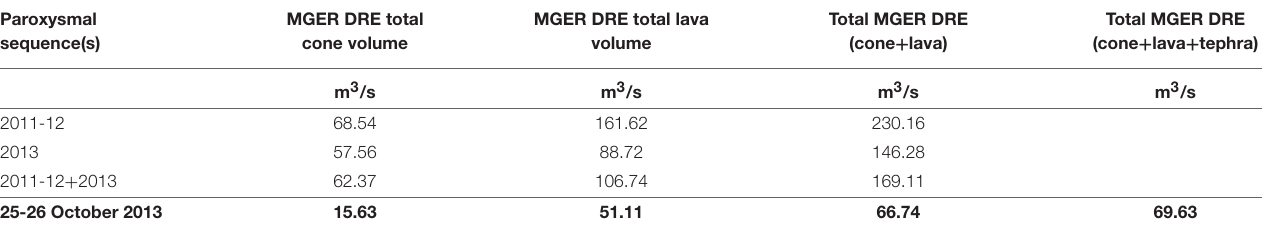
We reported: the MGER DRE total cone volume, the MGER DRE total lava volume, the sum of the previous values and the MGER DRE tephra (see Table 2 ). DRE, dense rock equivalent; MGER, magma eruption rate.